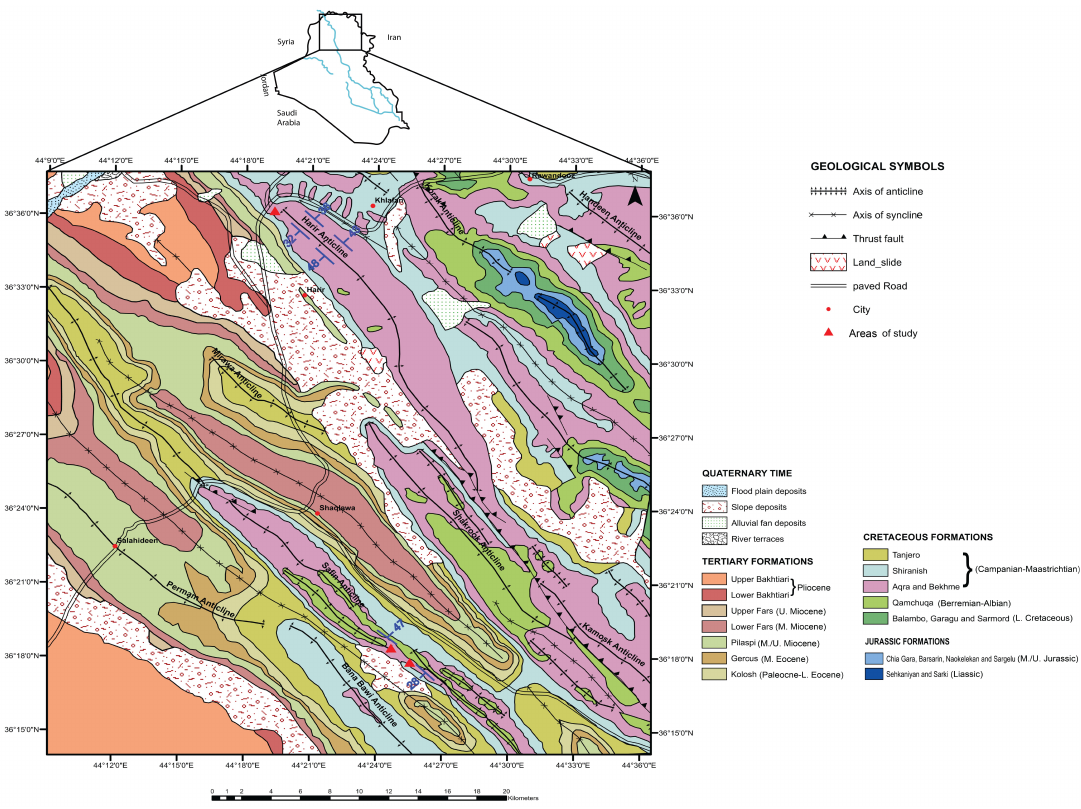
Figure 2. Geologic map of the Upper Cretaceous and Tertiary Basins showing related tectonic elements, geological units, facies distribution, and location of studied (Spelek–Sulauk areas) in the High Folded Zone.